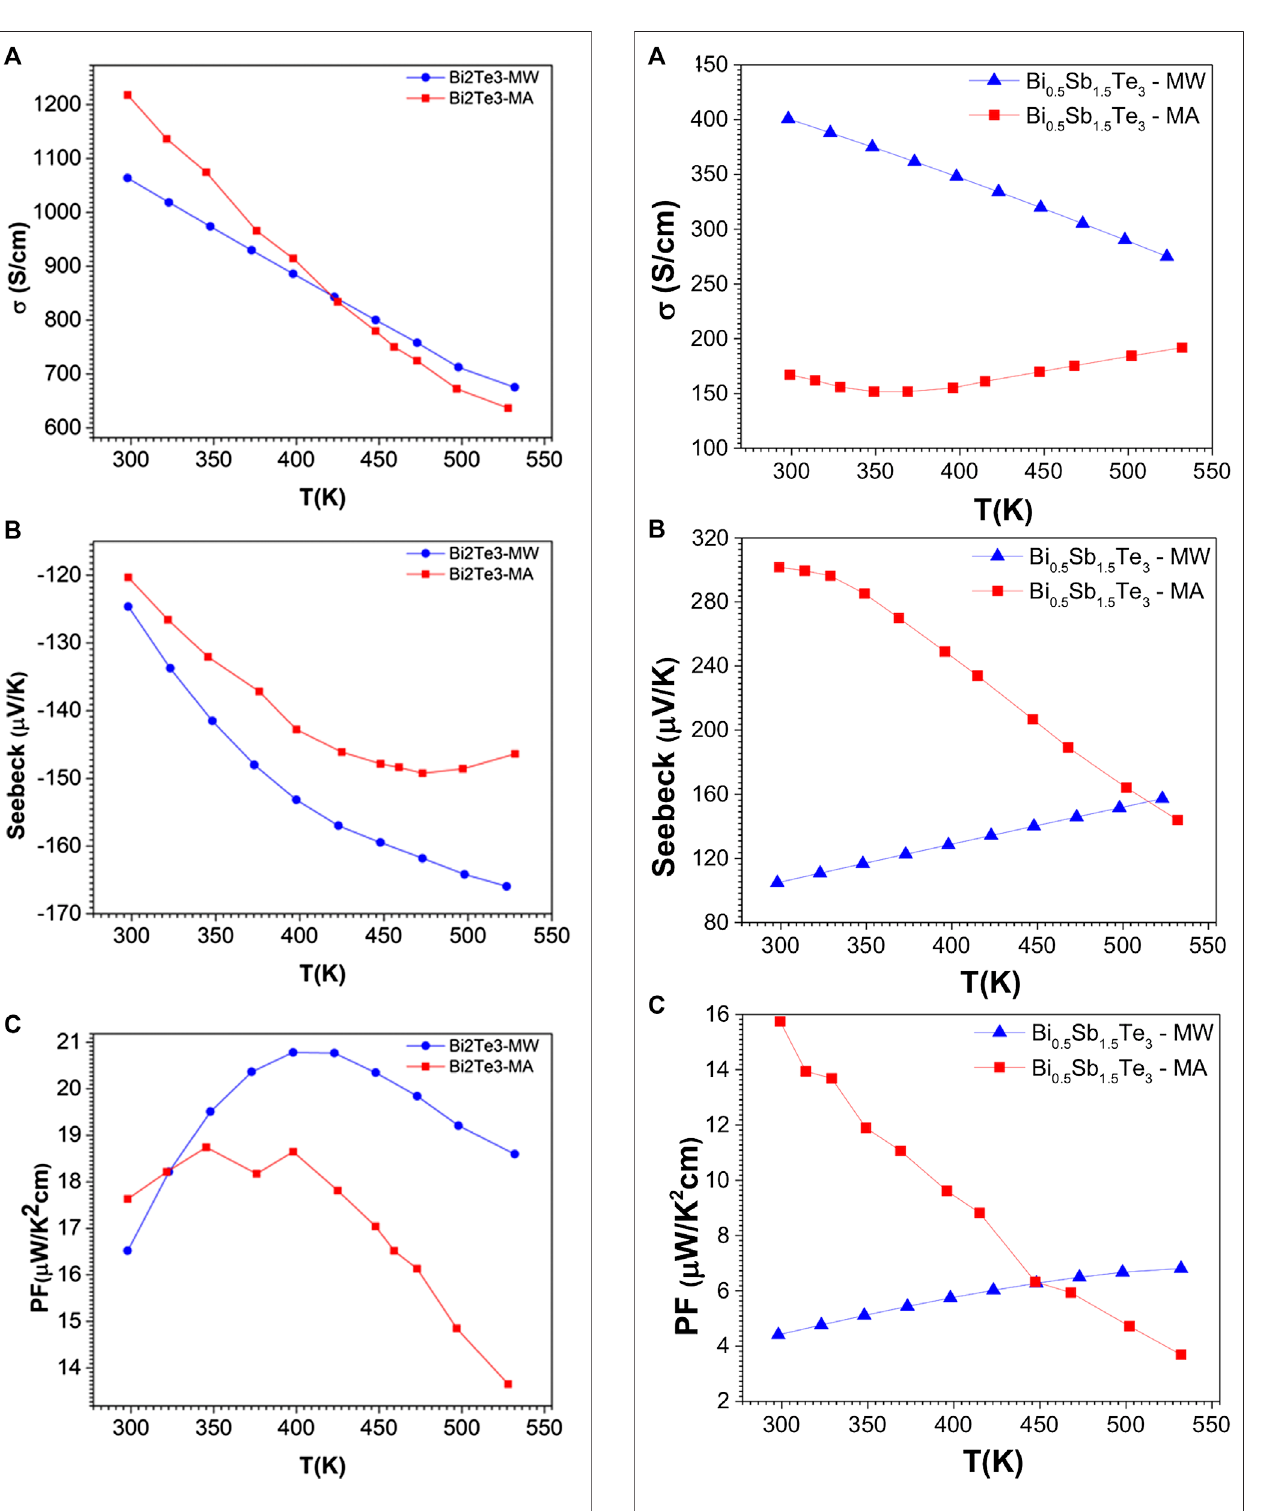
Frontiers in Materials |